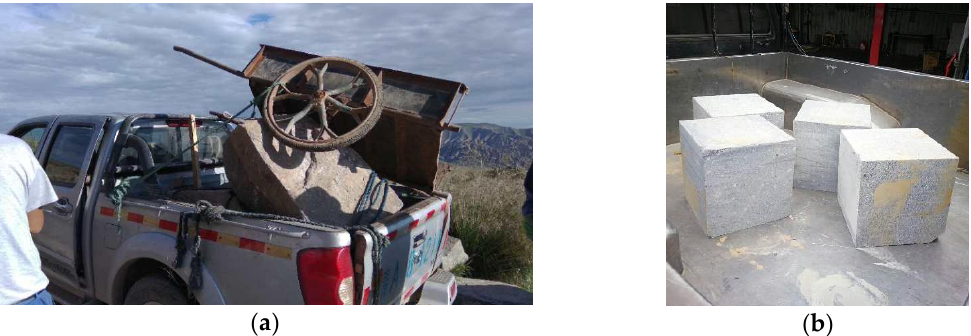
Figure 1. The Songliao Basin map with the location of the Daqing Oilfield and YS-2 well.